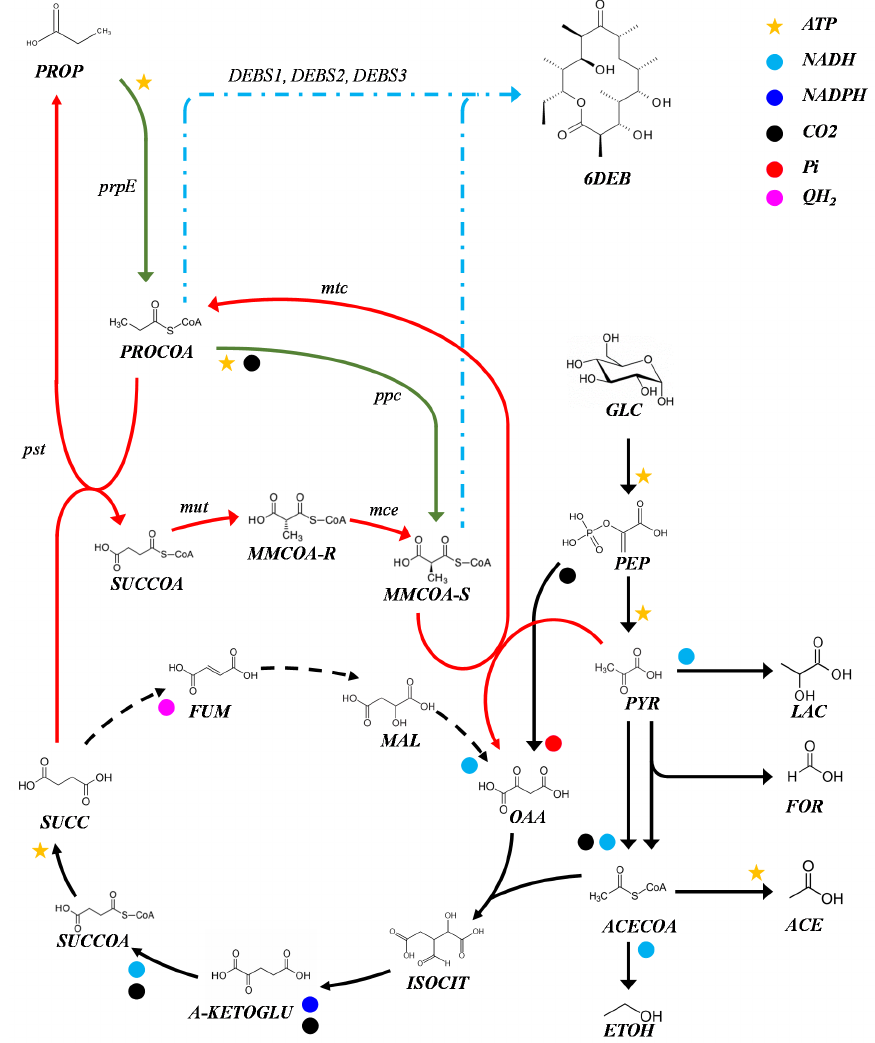
Figure 1. Production of 6-deoxyeritronolide B in E. coli . Key metabolites and cofactors are shown. E. coli ’s native metabolism is shown in black. Engineered propionate assimilation pathway is shown in green. The Wood Werkman cycle is shown in red. 6-dEB synthesis is shown in blue. The main genes involved in the pathways sourcing precursors propionyl-CoA and S -methylmalonyl-CoA are shown. Under anaerobic conditions, the reactions shown in dashed lines occur in the reverse direction as indicated. Propionate assimilation occurs through a propionyl-CoA synthetase ( prpE ).